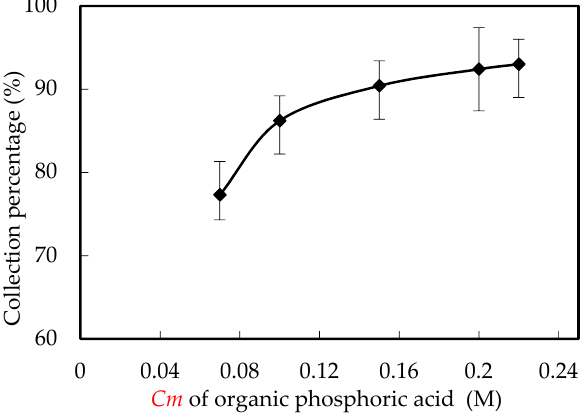
Figure 10. Influence of organic phosphoric Cm .